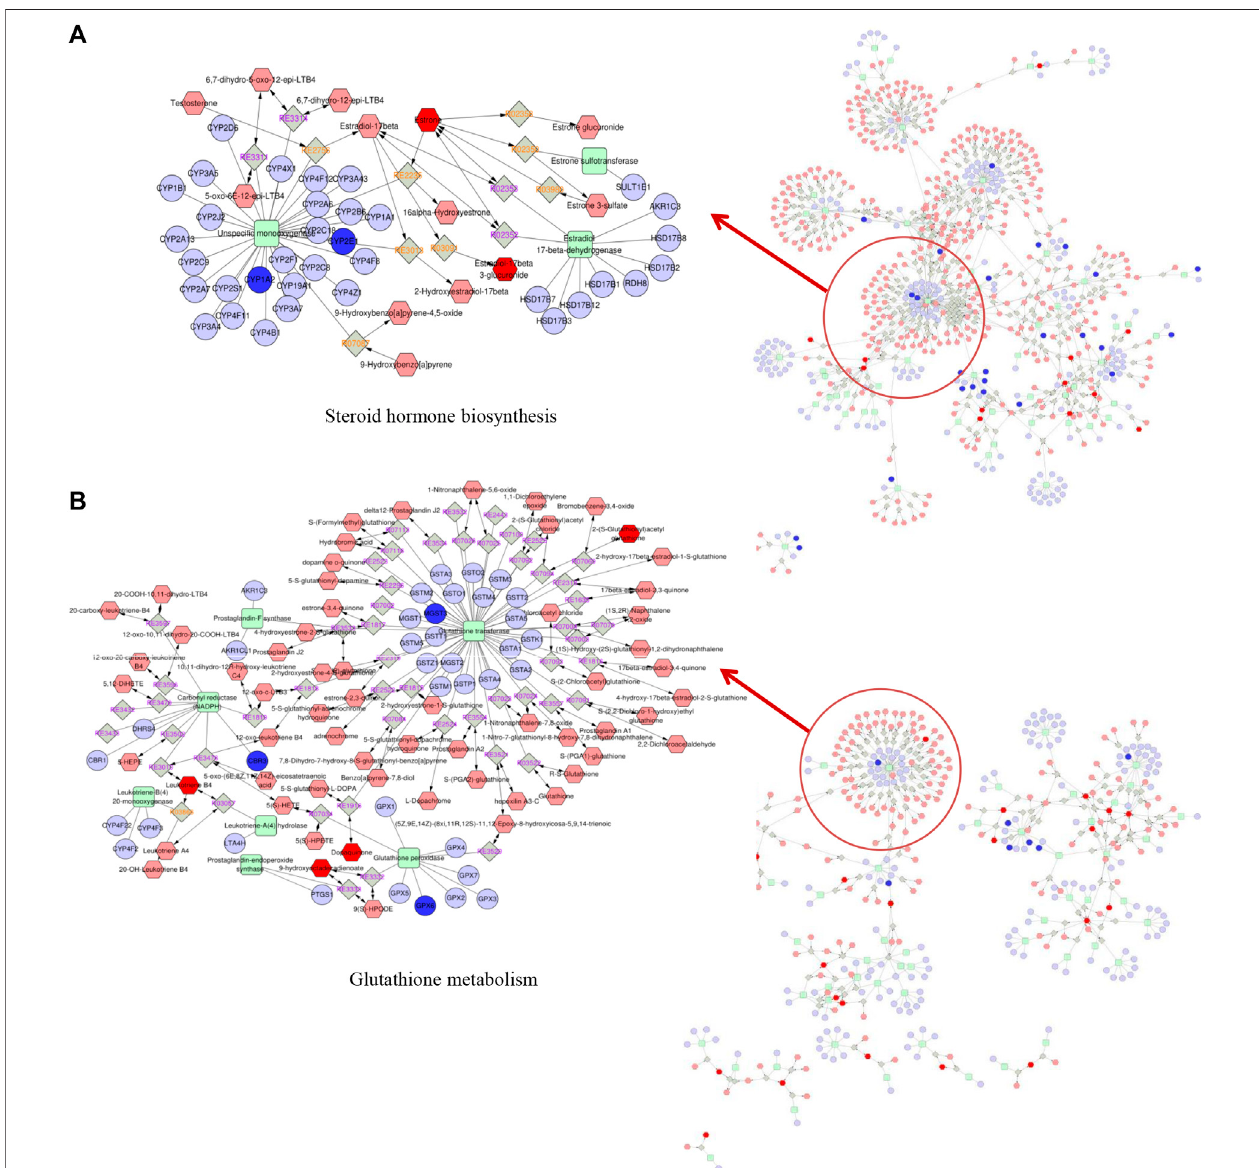
FIGURE5| Metabolic pathways werevisualizedbymeansofCytoscape software.Integratedanalysisofthemechanismunderlyingtheeffects ofAAItreatmenton mice based on metabolomic and transcriptomic data by means of Cytoscape software. (A) Network built in AAI-treated neonatal mice. (B) Network built in AAI-treated adult mice. The metabolic biomarkers are represented by red hexagons and genic biomarkers are represented by blue circles in our study.